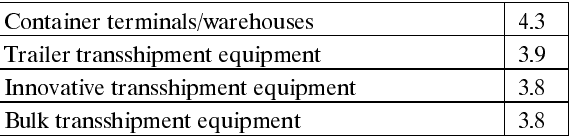
Table 4. Technical / logistics aspects relevant to sharing by